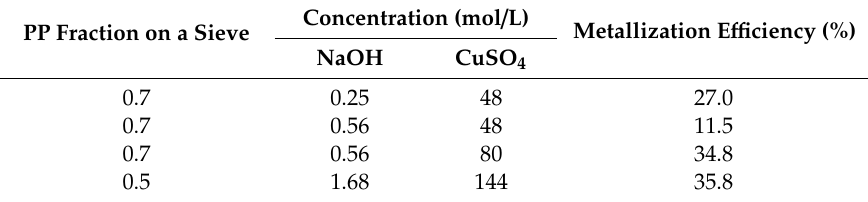
Table 2. The e ffi ciency of metallization of activated